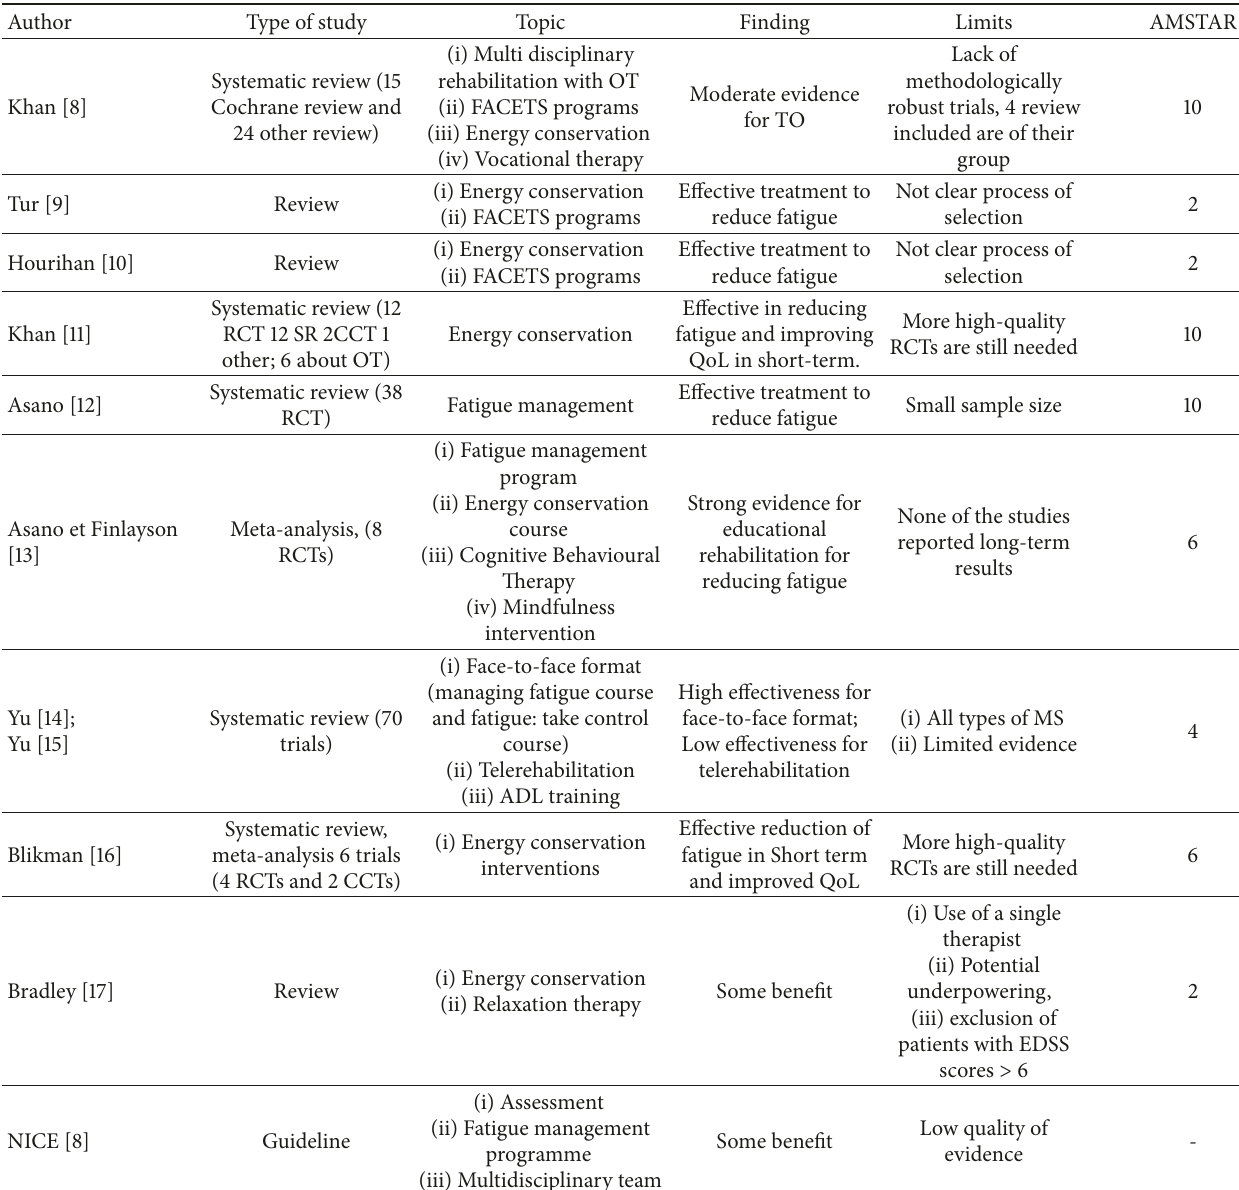
Table 3: Included review characteristics and results. MS: multiple sclerosis; OT: occupational therapy; RCT: randomized clinical trial; SR: systematic review; CCT: controlled clinical trial, AMSTAR: Assessment of Multiple Systematic Reviews; QoL: quality of life: ADL: activity of daily living; EDSS: Expanded Disability Status Scale, FACETS: Fatigue: Applying Cognitive behavioural and Energy effectiveness Techniques to life